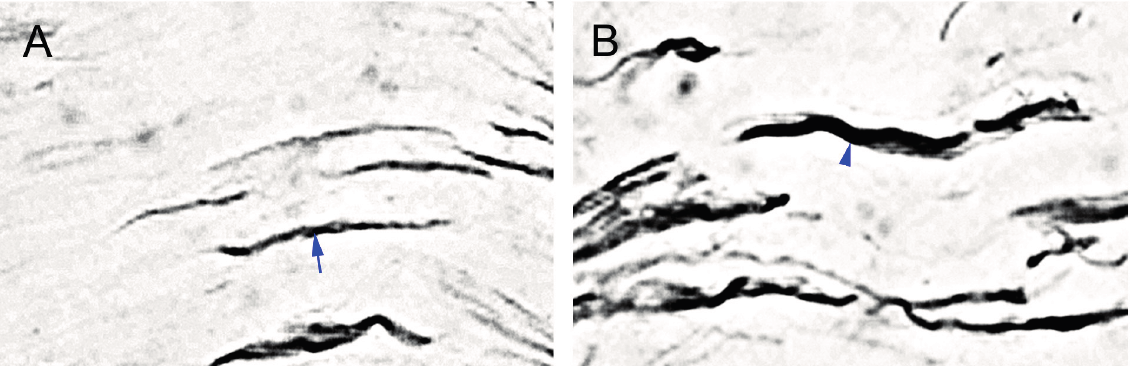
Figure 5. The pharmacological effects of MPEP on the CCI-induced peripheral hypersensitivities. The effects of MPEP, a selective mGluR5 antagonist, were applied on CCI by intraplantar injections to assess the ( A ) thermal hyperalgesia and ( B ) mechanical allodynia following post-injection hour (PIH). The differences in withdrawal latency and mechanical threshold were calculated by subtracting the responses of contralateral side from the responses of ipsilateral side and presented as the mean ± SD. The properties of MPEP were verified at the concentration of 500 mM (filled circles with solid line) and 250 mM (filled circles with dash line), and vehicle (open circles with dotted line) ( n = 6 per group). Student’s t test was applied to examine the differences compared to vehicle injections at the same time points. One-way repeated measures ANOVA was also used to analyze the within-group differences following Dunnett’s multiple comparison tests. * p < 0.05, indicated as a significant